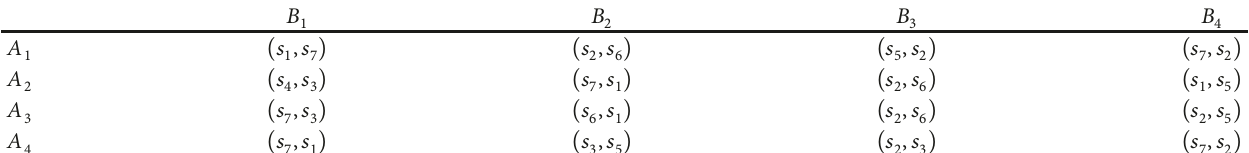
Table 2: The linguistic Pythagorean fuzzy preference information matrix 𝐿 2 provided by the decision-maker 𝑀 2 . 𝐵 1